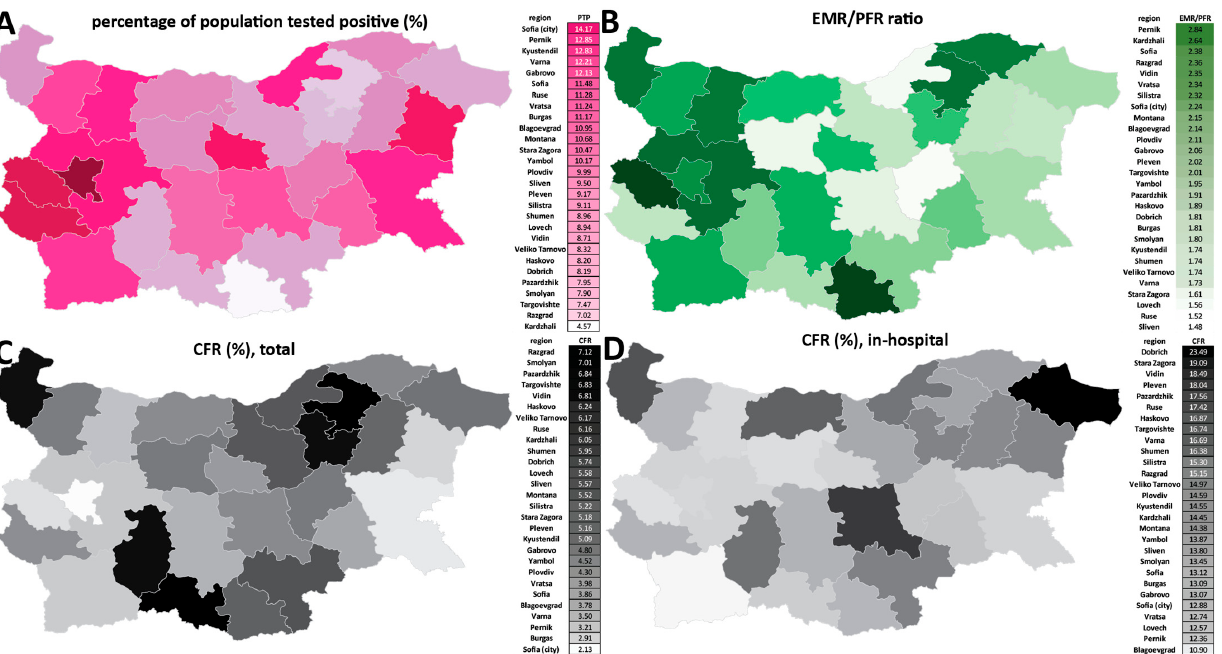
Figure 6. Regional discrepancies in the extent of recording of the impact of the COVID-19 and hospital outcomes in Bulgaria . ( A ) Percentage of the population that has tested positive for SARS- CoV-2 in Bulgarian regions; ( B ) undercount ratio for Bulgarian regions; ( C ) total CFR values for Bulgarian regions; ( D ) in-hospital CFR values for Bulgarian regions.